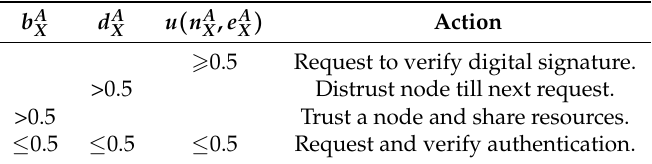
Table 1. Trust judgment rules to authenticate a node at a certain security